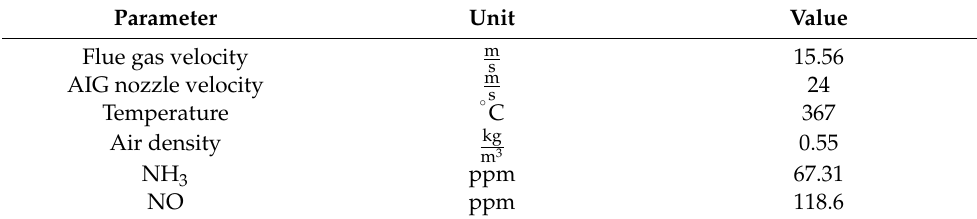
Figure 3. Definition sketch of the flow fields inside the SCR system. Table 1. Flow conditions.